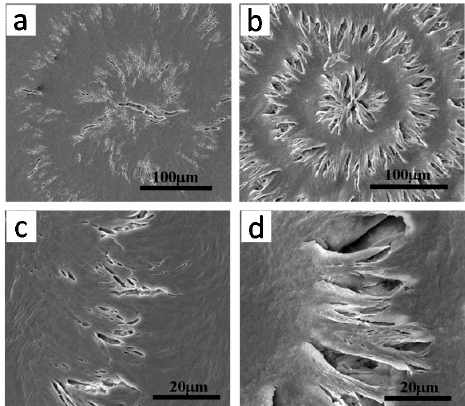
Figure 8. SEM micrographs for PHB/LM w -PLLA (50/50) blend samples ( T c = 120 °C): ( a ) unetched; ( b ) solvent-etched; and ( c , d ) zoom-in SEM graphs of the bright ridge band in ring-banded spherulites of Graphs ( a , b ), respectively. Reprinted with permission from Ref. [20]. Copyright (2011) American Chemical Society.